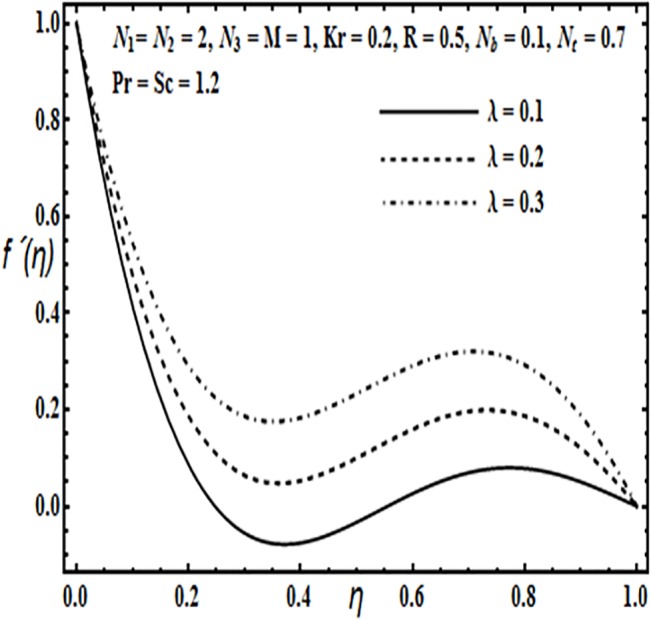
Effect of λ on f′(η).